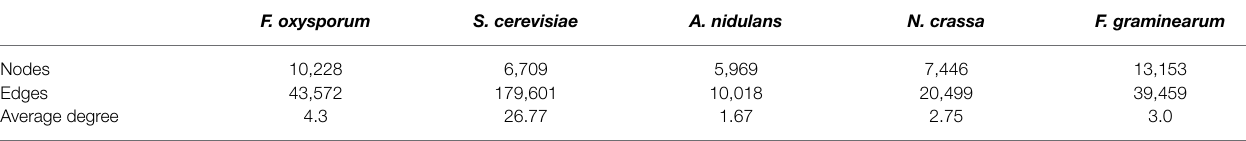
TABLE 1 | GRN of five species (four fungal models and F. oxysporum ).